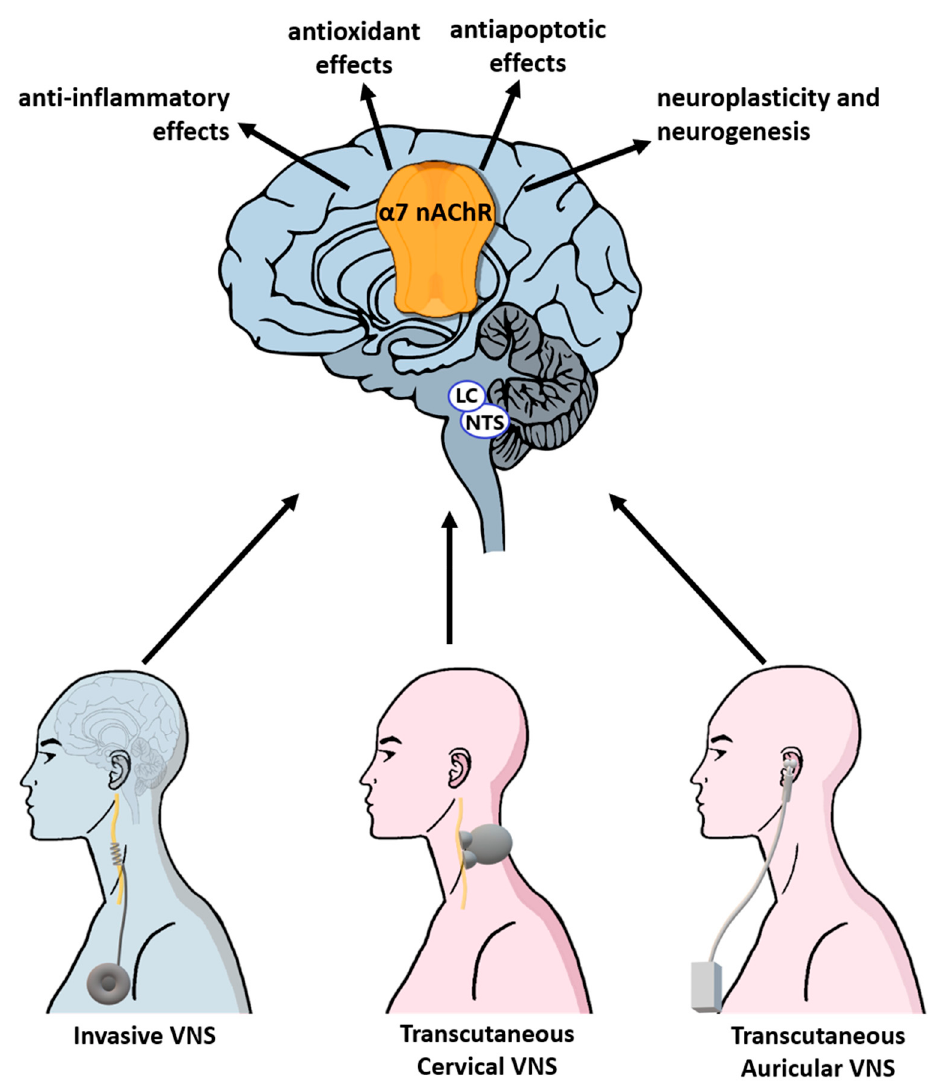
Figure 3. Central effects of invasive and non-invasive vagus nerve stimulation. Abbreviations: VNS, vagus nerve stimulation; LC, locus coeruleus; NTS, nucleus tractus solitarius; α 7nAchR, α 7 nicotinic acetylcholine receptor.